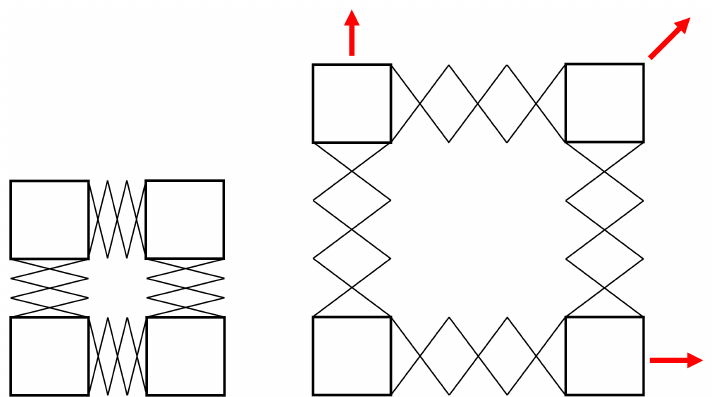
Figure 3. A square formation of scissor-hinge mechanisms expands as desired, with the bottom left block remaining stationary. Red arrows indicate the movement paths of the remaining blocks.